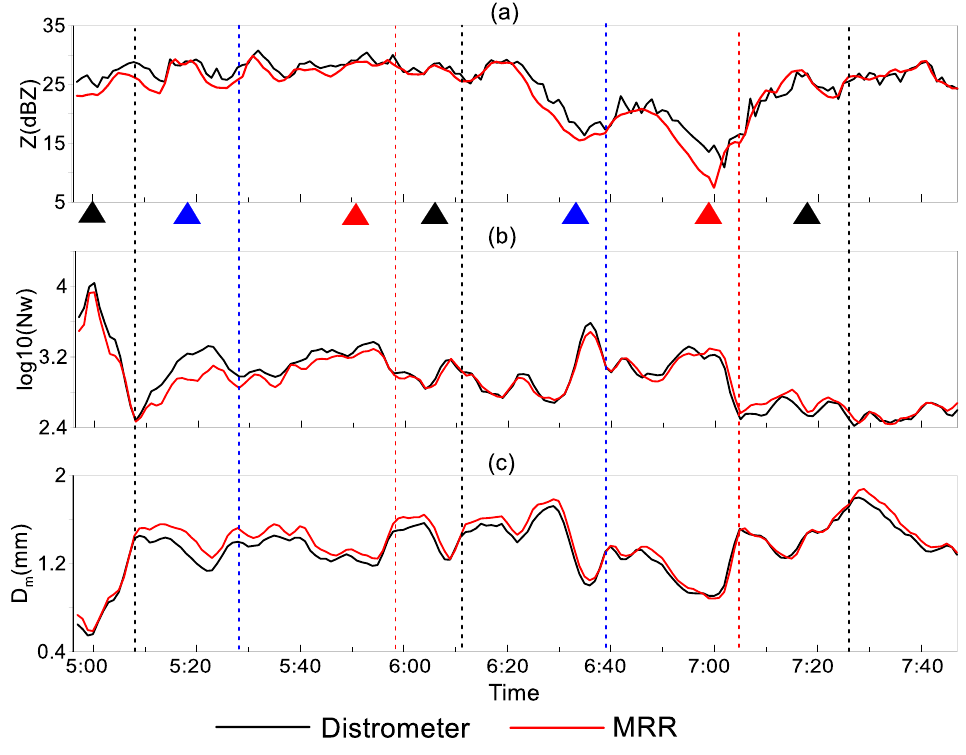
Figure 12. Time series of DSD parameters in stratiform rain detected by distrometer (black line) and MRR (red line) on 19 August 2021, from 4:47–7:57 with ( a ) Z (dBZ), ( b ) log10( N w ) and ( c ) D m (mm). The triangles with colors on the horizontal axis to mark the BP occurring time, and the dotted lines with colors marked the ending moment of BS.